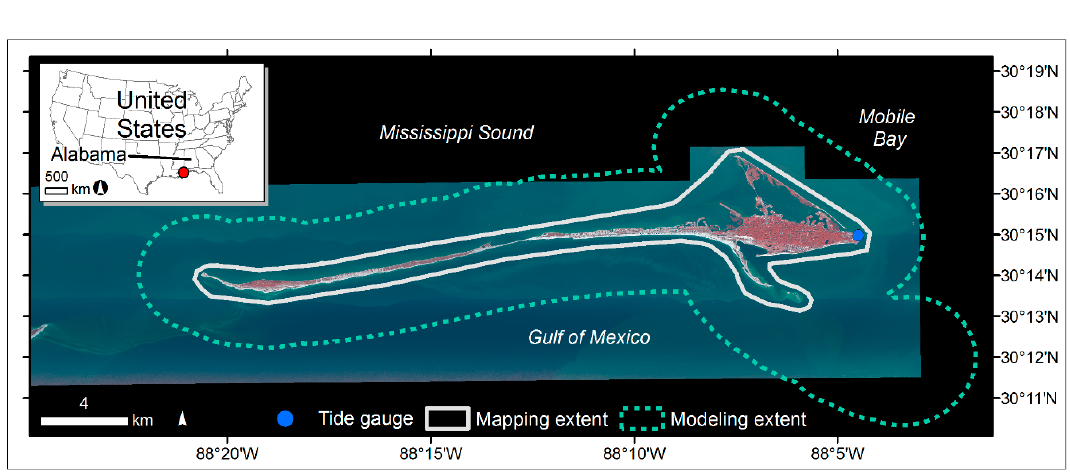
Figure 2. Modeling domain and the extent of baseline mapping data for habitat modeling effort on Dauphin Island, Alabama, USA. The basemap source data is 0.3 m color-infrared orthophotography acquired in December 2015 by Digital Aerial Solutions, LLC (Riverview, Florida, USA) and the U.S. Geological Survey (USGS). The area that is outside the 2015 imagery acquisition zone is shown in black.